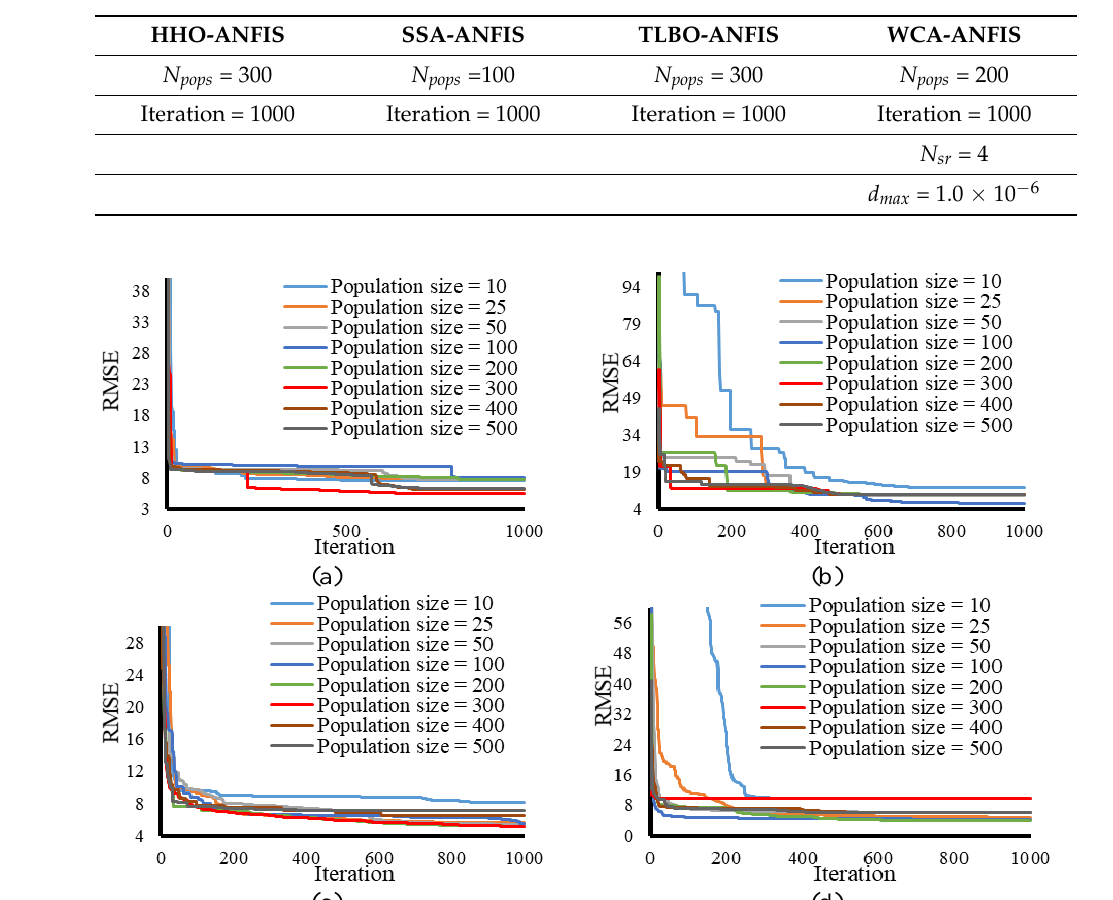
ANFIS, and ( d ) WCA – ANFIS.